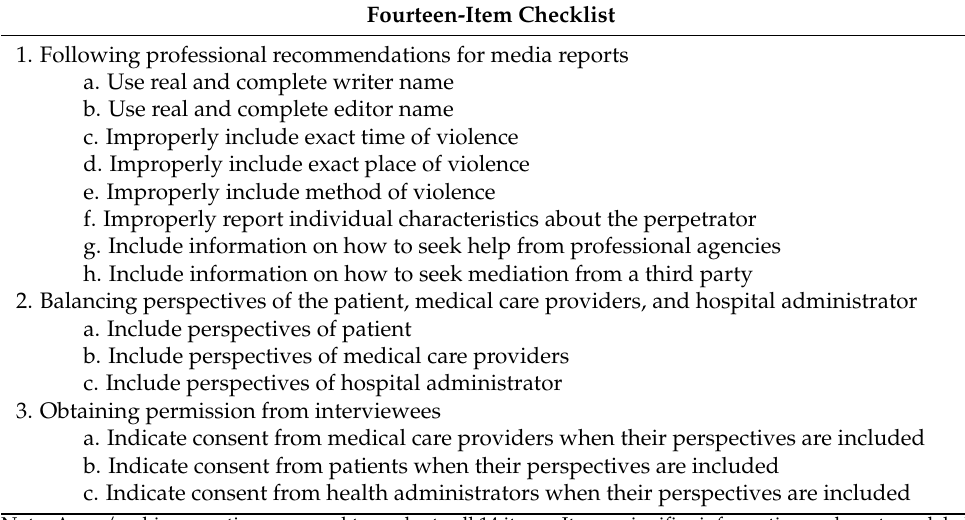
Table 1. Fourteen-item checklist to evaluate adherence to professional journalism